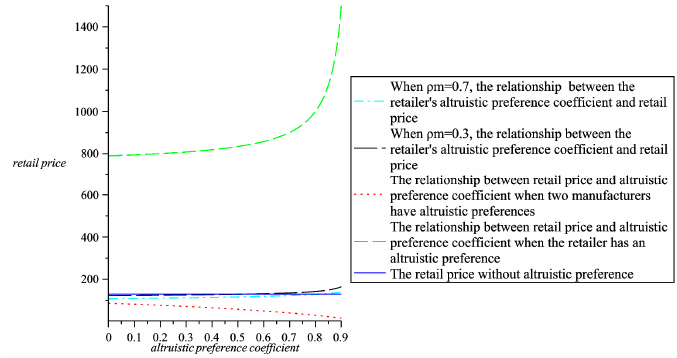
Figure 12. The relationship between retail prices and altruistic preference coefficients in four models.